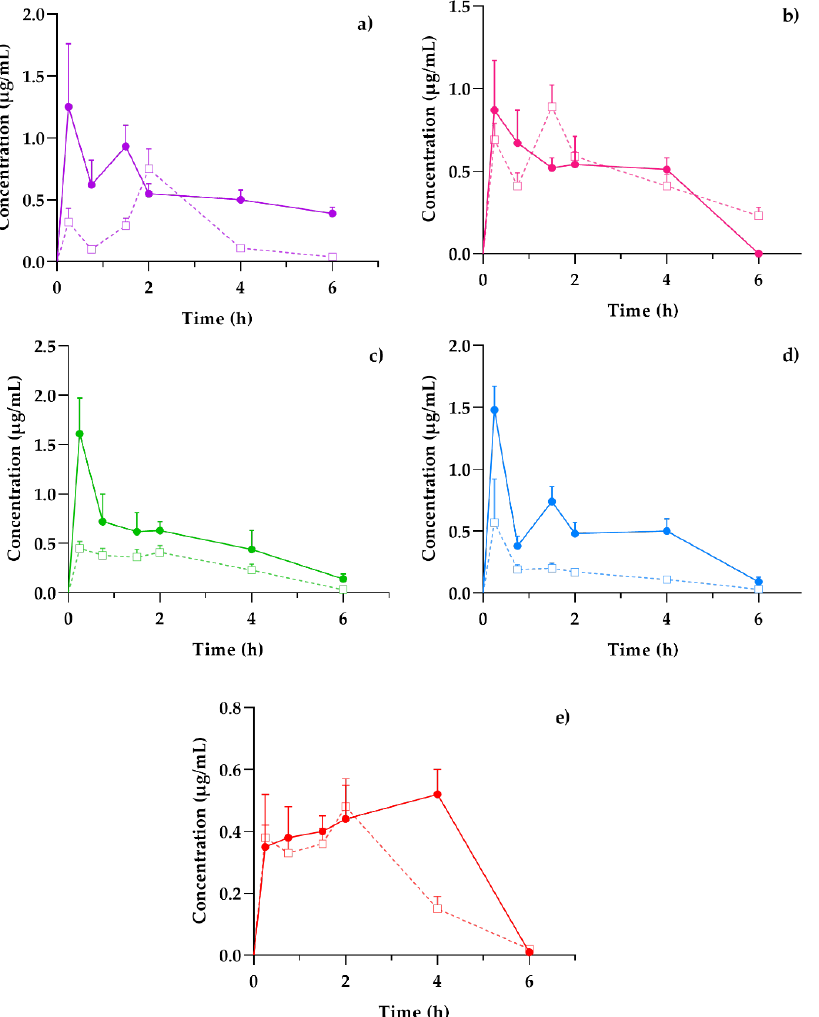
Figure 3. Concentration–time profiles of coumarins: ( a ) PE, ( b ) SC, ( c ) DF, ( d ) HR, and ( e ) PU after a 10 mg/kg oral dose administration of hexanic extract of Tagetes lucida in healthy (-□-) and